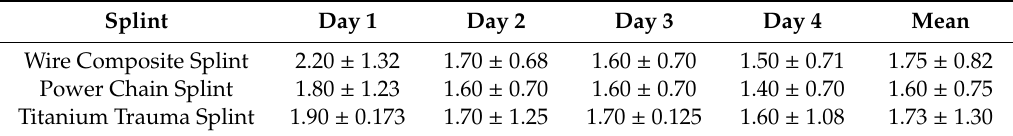
Table 5. Impairment of speech and eating.